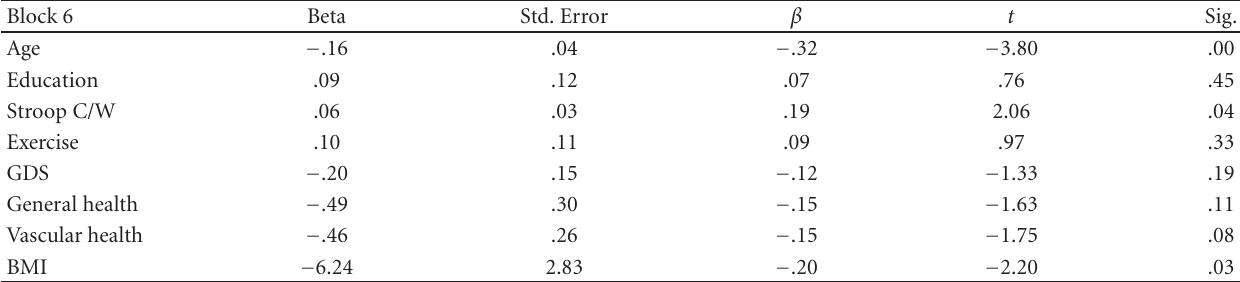
Table 5: Contribution of demographics, cognition, depression, exercise and health variables to